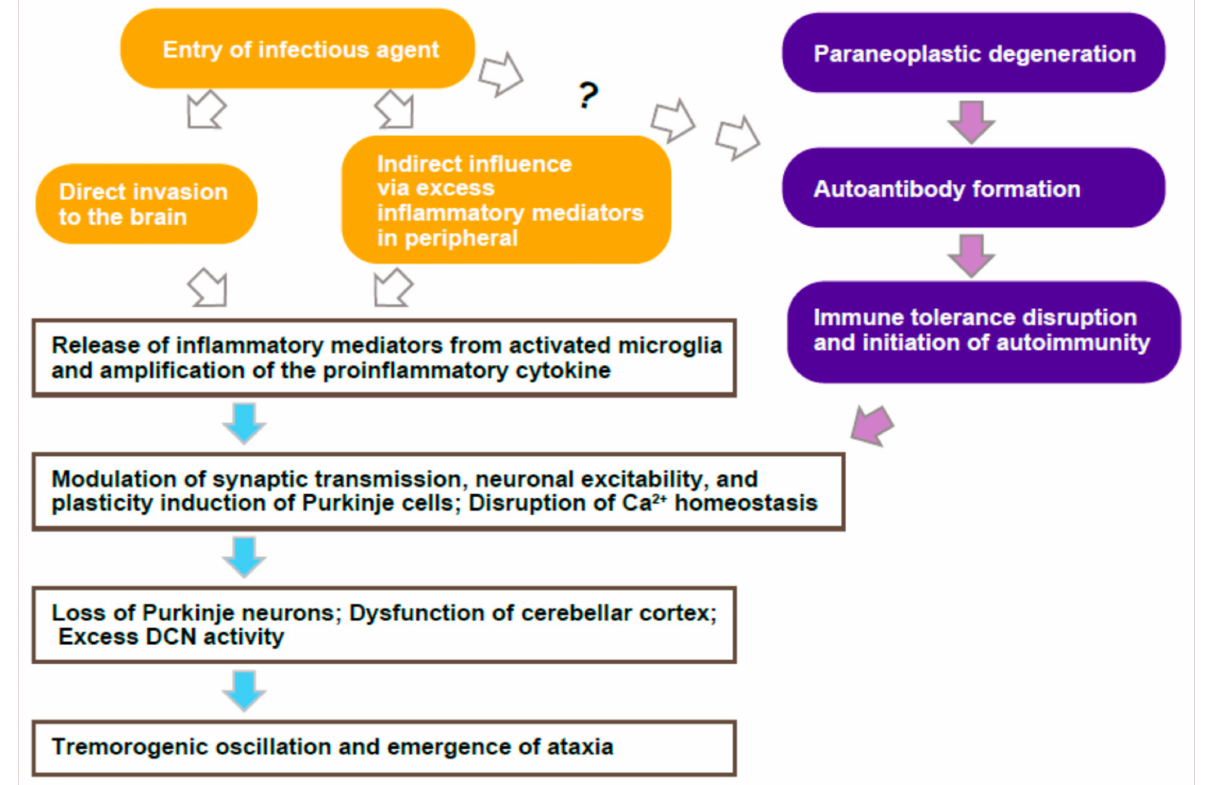
Figure 2. Schema of Cerebellar Ataxia by Infection and Autoimmunity. Infectious agents induce cere- bellar inflammation through their direct invasion to the brain or indirectly via influencing excessive inflammatory mediators in the peripheral, resulting in the activation of microglia and the release of excessive inflammatory cytokines. Activated microglia and excessive inflammatory mediators cause neurophysiological modulation of synaptic transmission, plasticity induction of Purkinje cells, and disruption of Ca 2+ homeostasis, leading to the loss of Purkinje neurons, dysfunction of the cerebellar cortex, and excess DCN activity, followed by tremorogenic oscillation and emergence of ataxia. The formation of autoantibodies is triggered by infectious agents and paraneoplastic degeneration. Although the exact mechanism of autoantibody formation by infection is unclear, autoantibodies disturb the immune tolerance and induce autoimmunity in the cerebellum, resulting in the neurophysiological modulation, plasticity, and disruption of Ca 2+ homeostasis, merging to the ataxia-generating